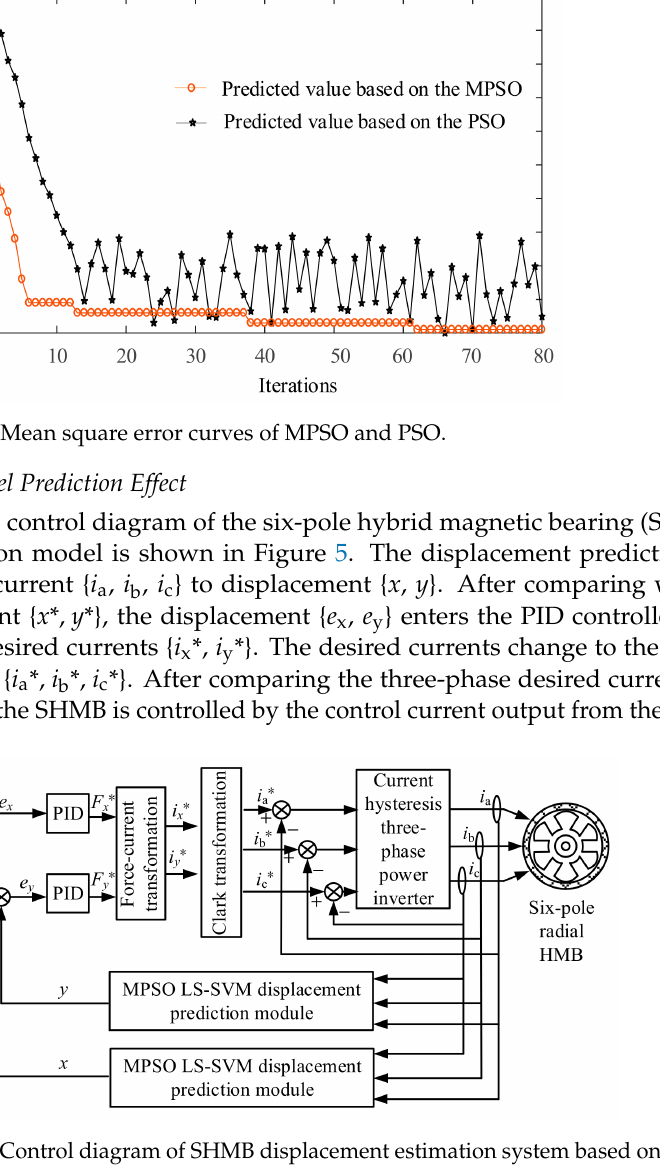
Figure 5. Control diagram of SHMB displacement estimation system based on MPSO LS-SVM